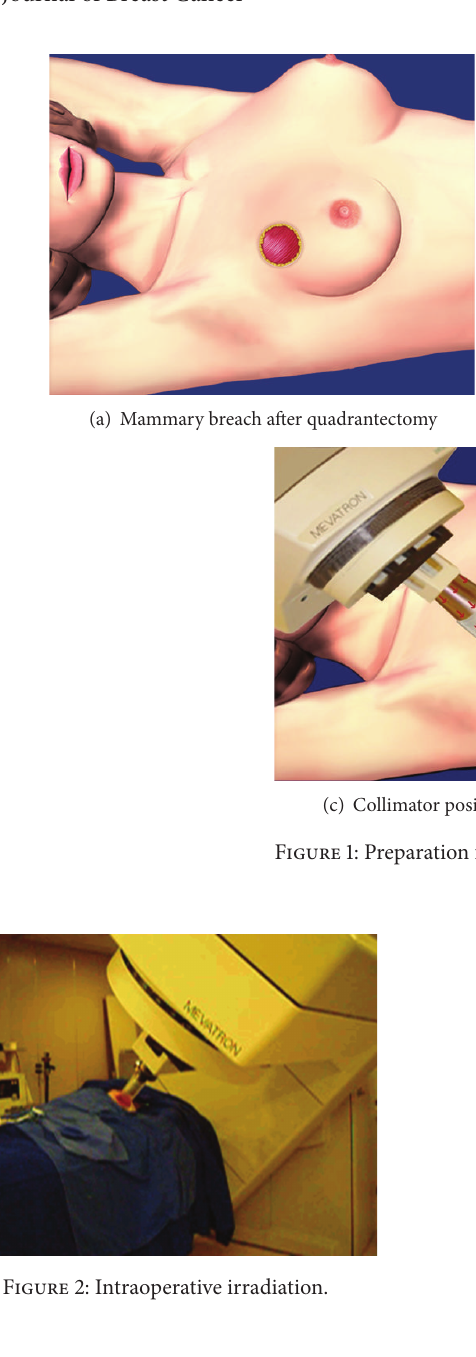
treatment were considered as “early” and after 6 months as